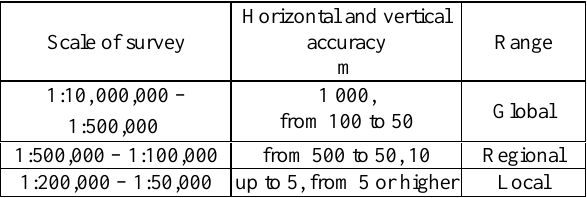
Table 1. Classification of surveys as DTM source data